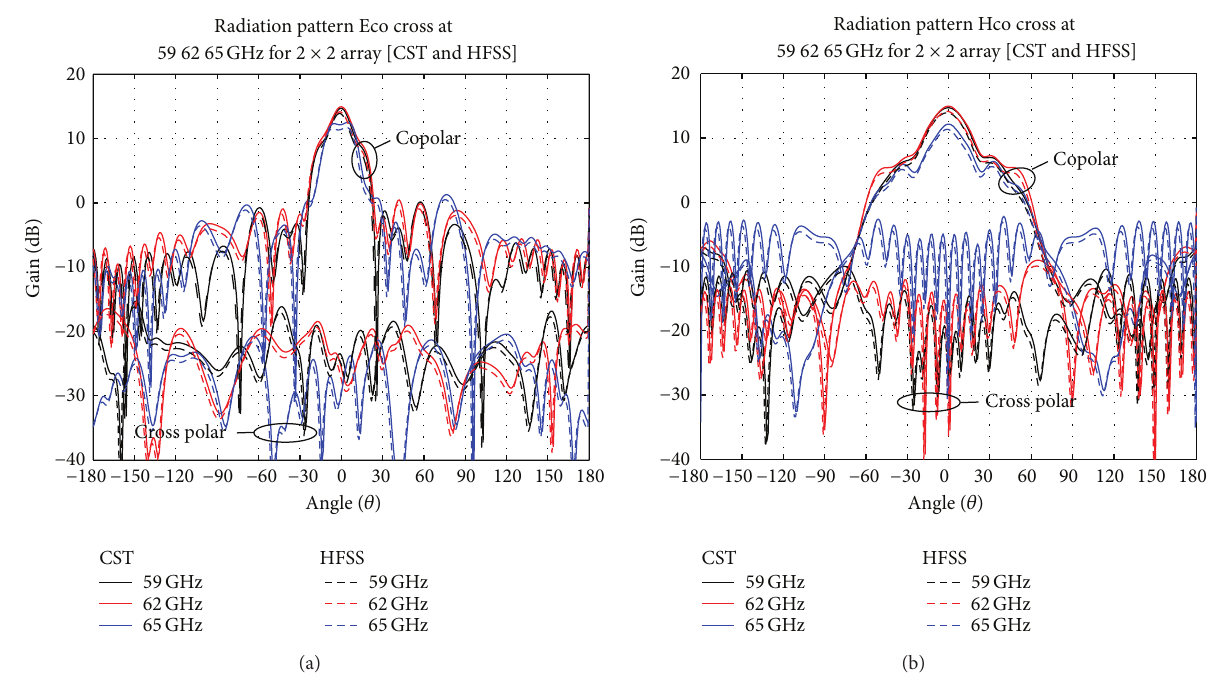
Figure 7: (a) E-plane radiation pattern at 59, 62, and 65 GHz for 2 × 2 array and (b) H-plane radiation pattern at 59, 62, and 65 GHz for 2 × 2 array.